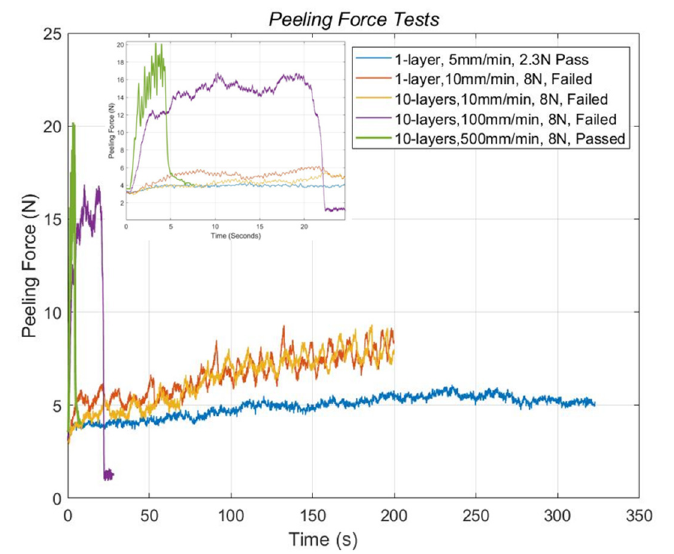
Figure 11. Peeling force tests of printed samples on non-chemical-treated (1-layer samples) and chemical-treated substrates (10-layer samples).